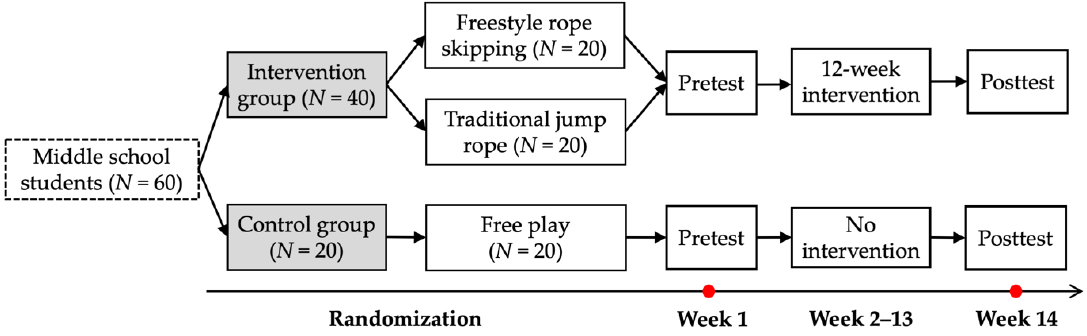
Figure 1. Procedures of the summarized intervention study.